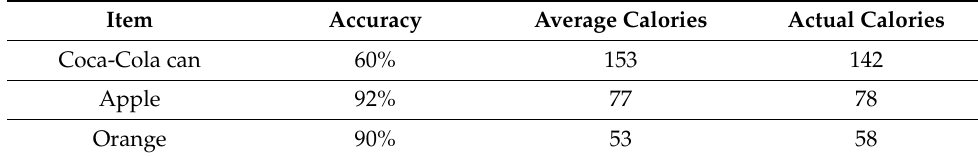
Table 2. Results from the real environment